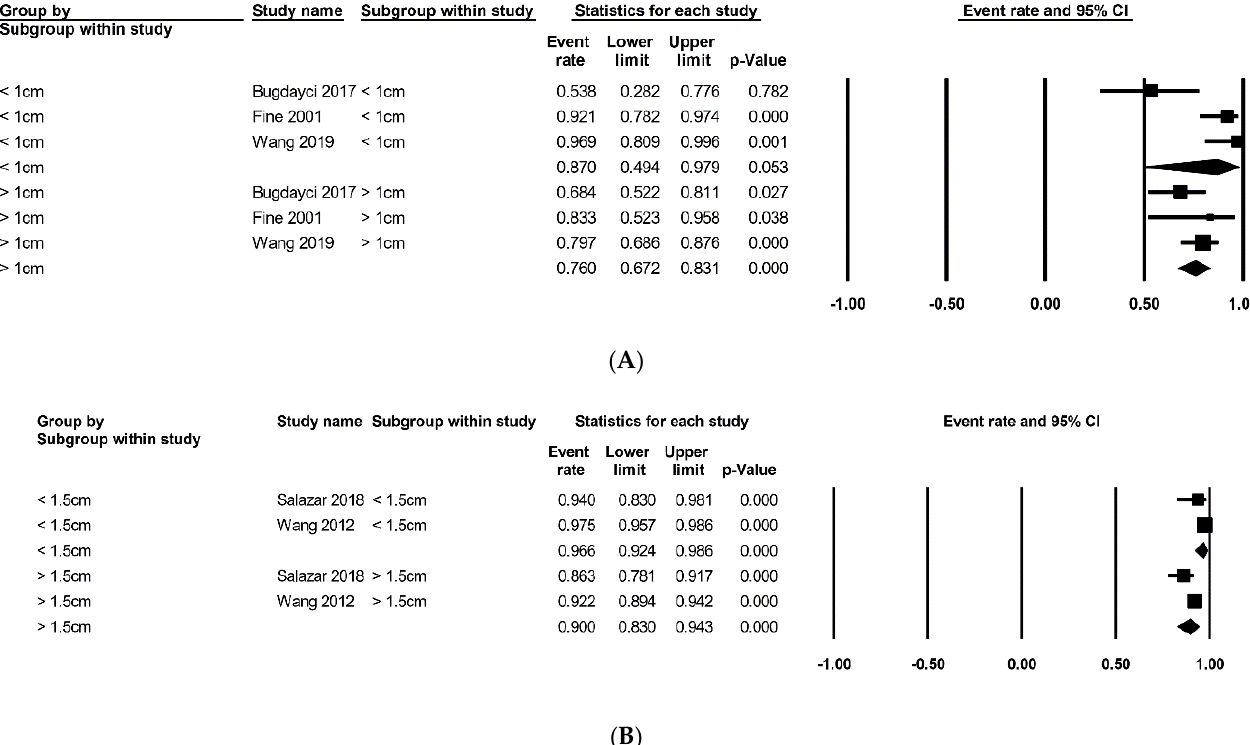
Figure 2. The estimated rates of complete resection in vacuum-assisted excision based on tumor size. ( A ) According to 1 cm of tumor size; ( B ) According to 1.5 cm of tumor size.